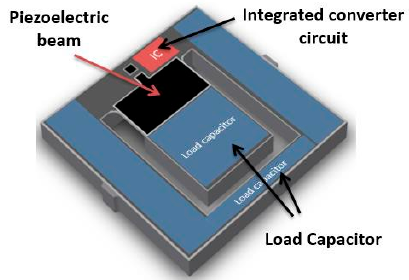
Figure 4. Diagram of the proposed monolithic system, composed by the converter circuit, capacitors and the piezoelectric MEMS structure for energy